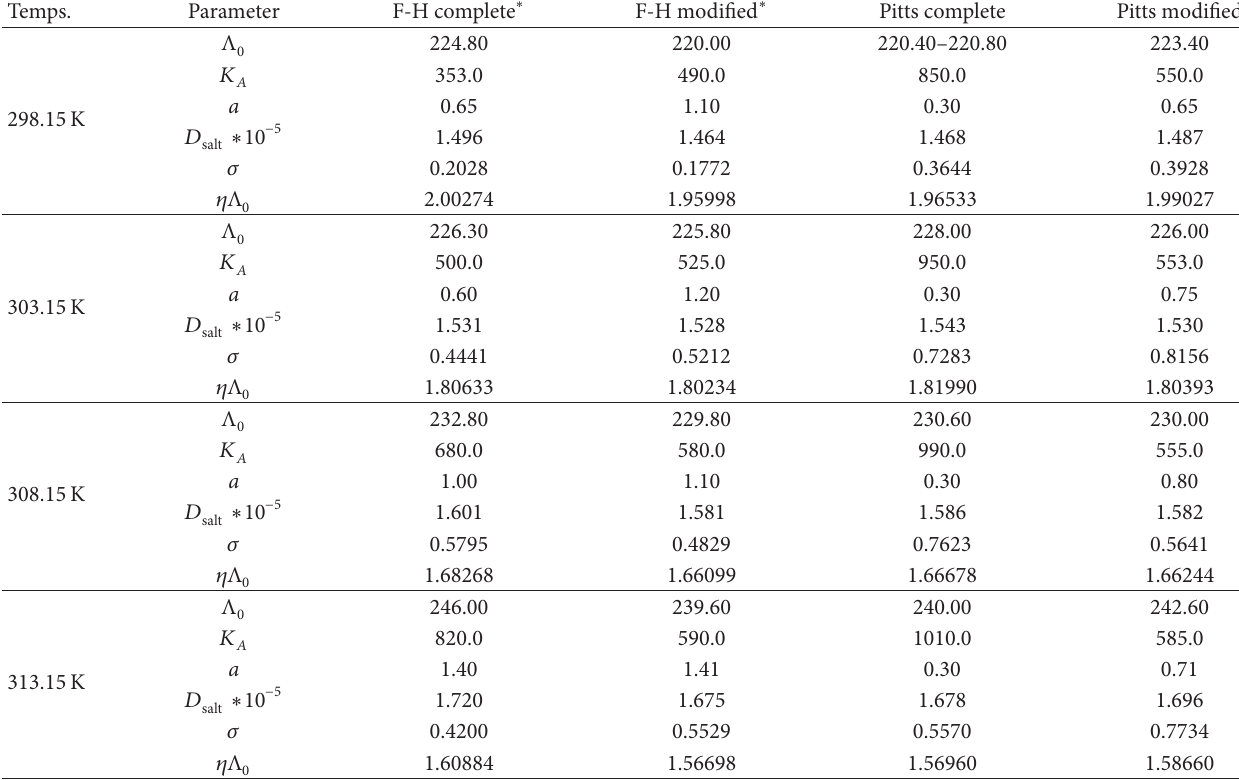
T 8: Best �t results for Mn-succinate.